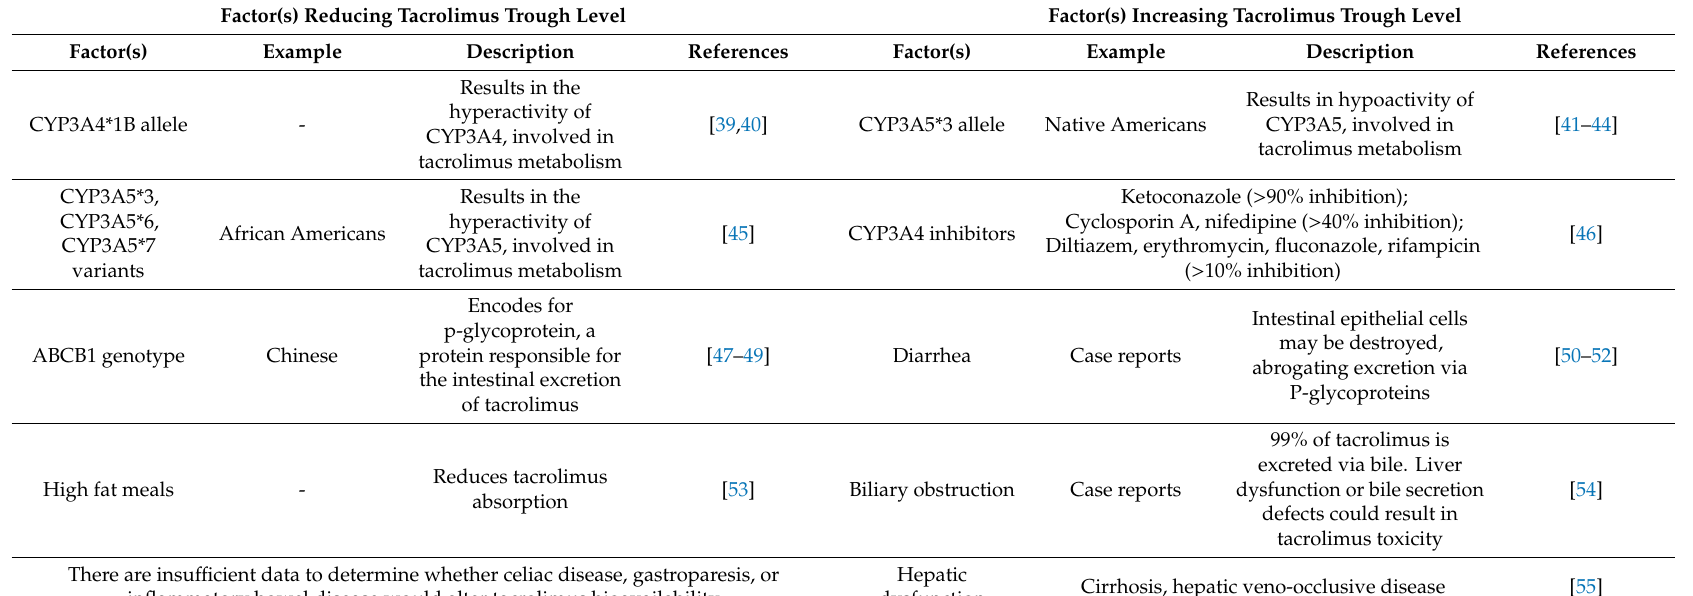
Table 2. Factors associated with alteration of tacrolimus trough